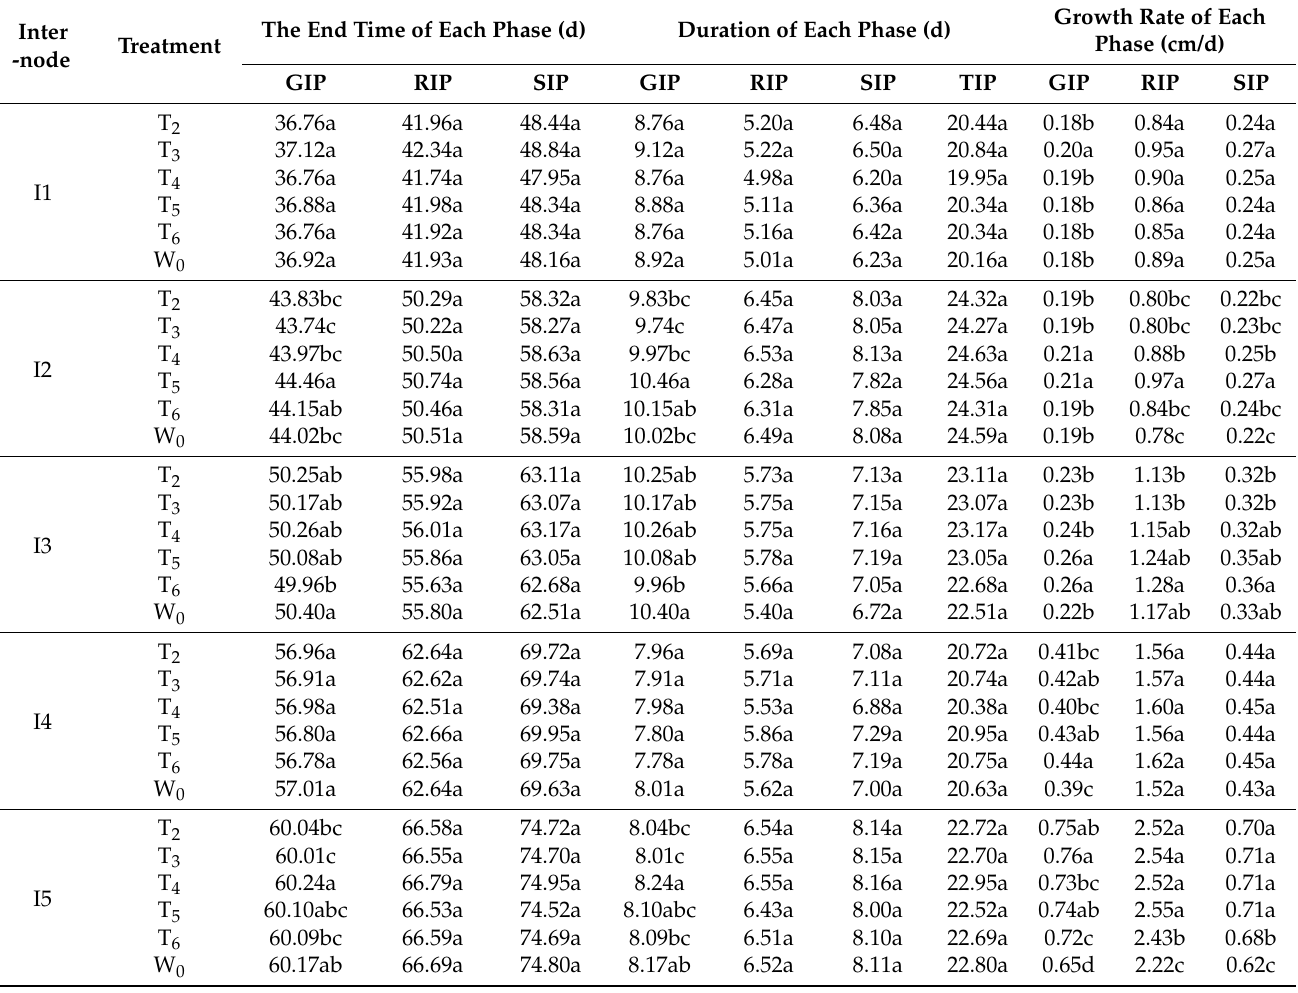
Table 5. Characteristic parameters of each internode growth process in the growing season from 2020 to